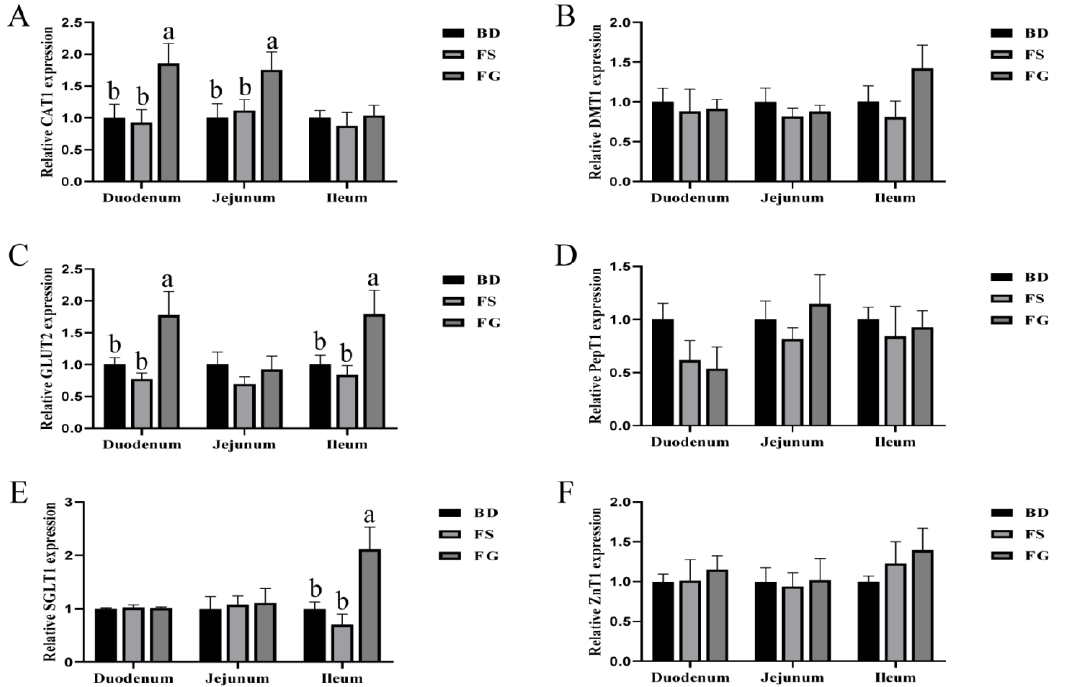
Figure 3. Effect of SPCI on the expression levels of critical genes related to nutrient digestion and ab ‐ sorption. CAT1 , amino acid transporter ‐ 1 ( A ); DMT1 , divalent metal transporter ‐ 1 ( B ); GLUT2 , glu